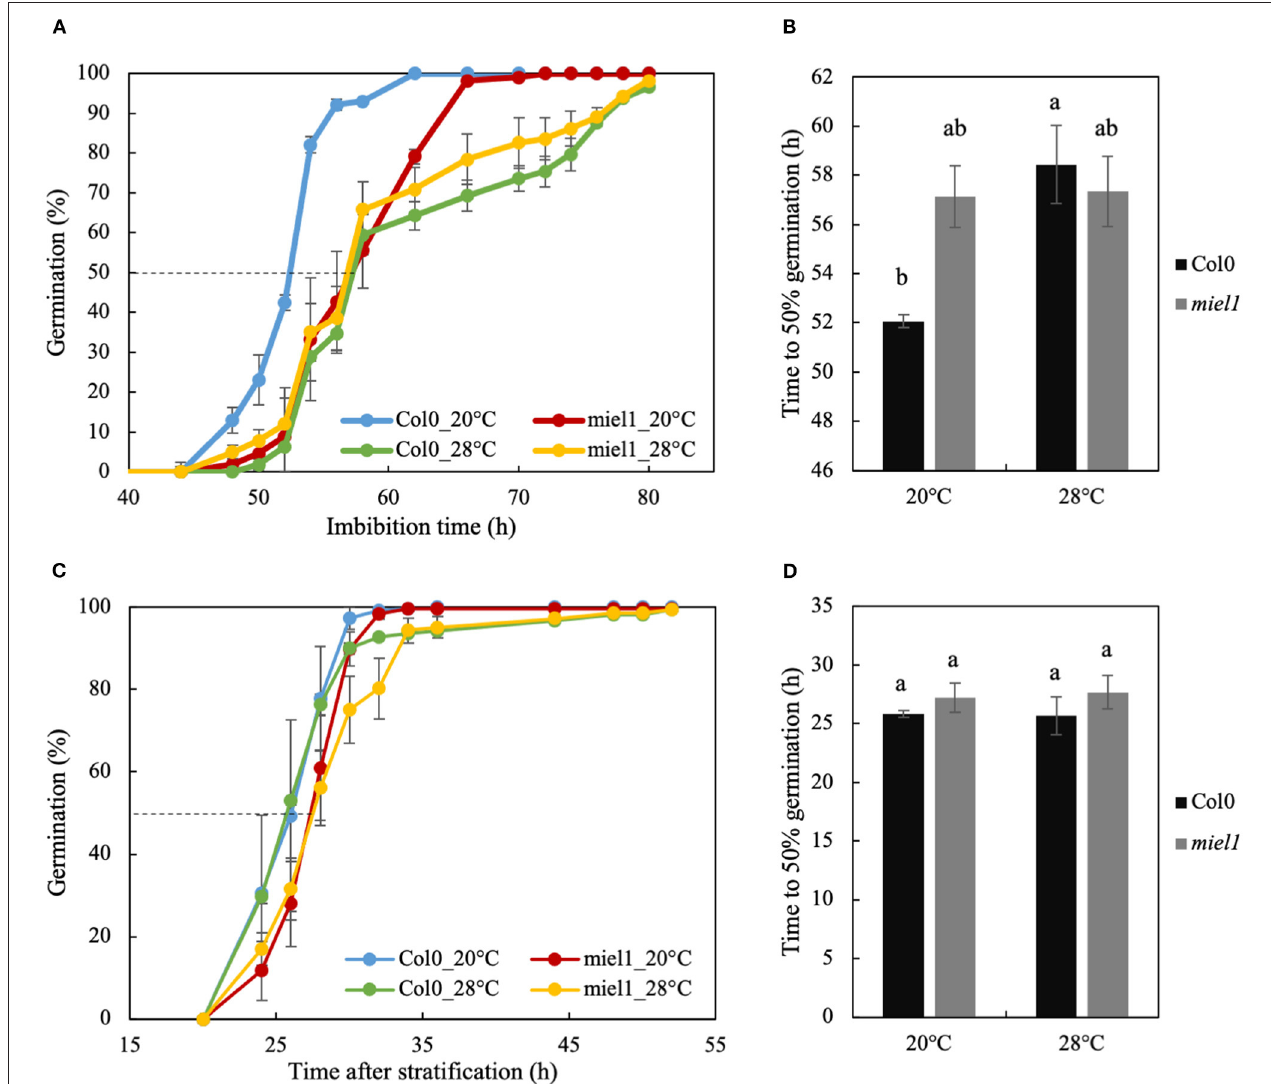
FIGURE 5 | Seed germination of Arabidopsis thaliana wild-type (Col-0) and miel1 T-DNA insertional mutant produced in optimal (20 ◦ C) and heat stress (28 ◦ C) conditions. (A,B) Germination curves and germination speed (T50) of freshly (dormant) harvested seeds of Col0 and miel1 mutant grown in optimal (20 ◦ C) and heat stress (28 ◦ C) conditions. (C,D) Germination curves and germination speed (T50) of mature seeds from Col0 and miel1 mutant after 72h of stratification at 4 ◦ C to release dormancy. Error bars represent standard errors of the mean. Different letters in b and d indicate significant differences between samples ( P < 0.05) identifying by ANOVA and Tukey’s honestly significant difference